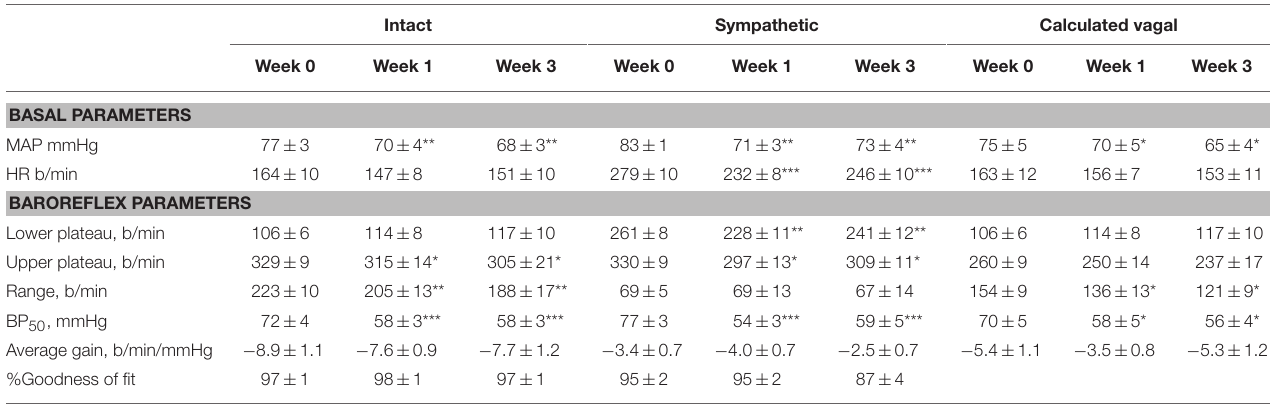
TABLE 2 | Average basal values and baroreflex parameters describing intact, sympathetic and calculated vagal MAP-HR curves before and at weeks 1 and 3 of subcutaneous administration of rilmenidine ( n =